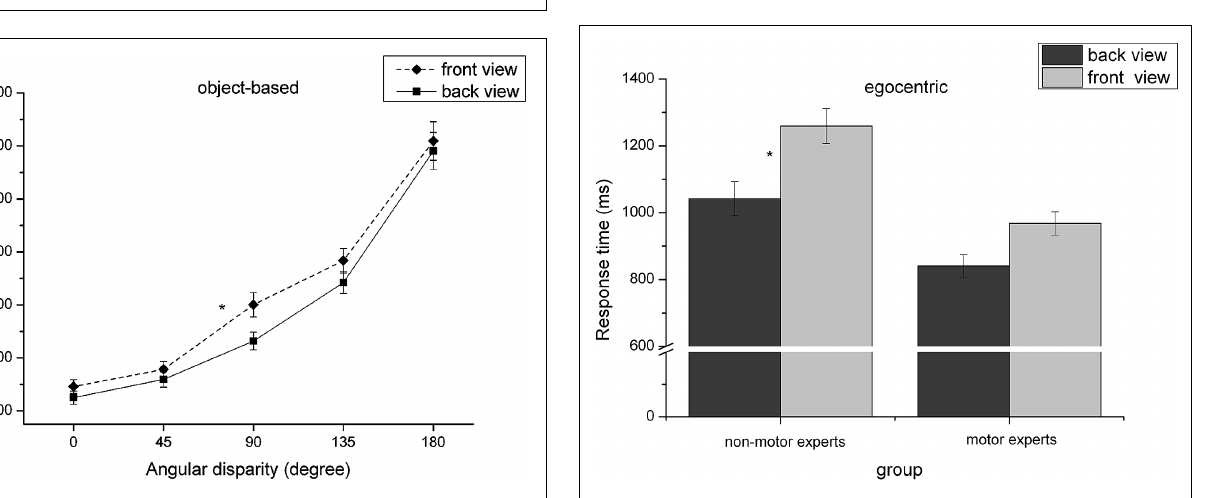
FIGURE 2 | Reaction time (mean and SE) dependent on view and stimulus type for the object-based transformations. * p < 0.05.